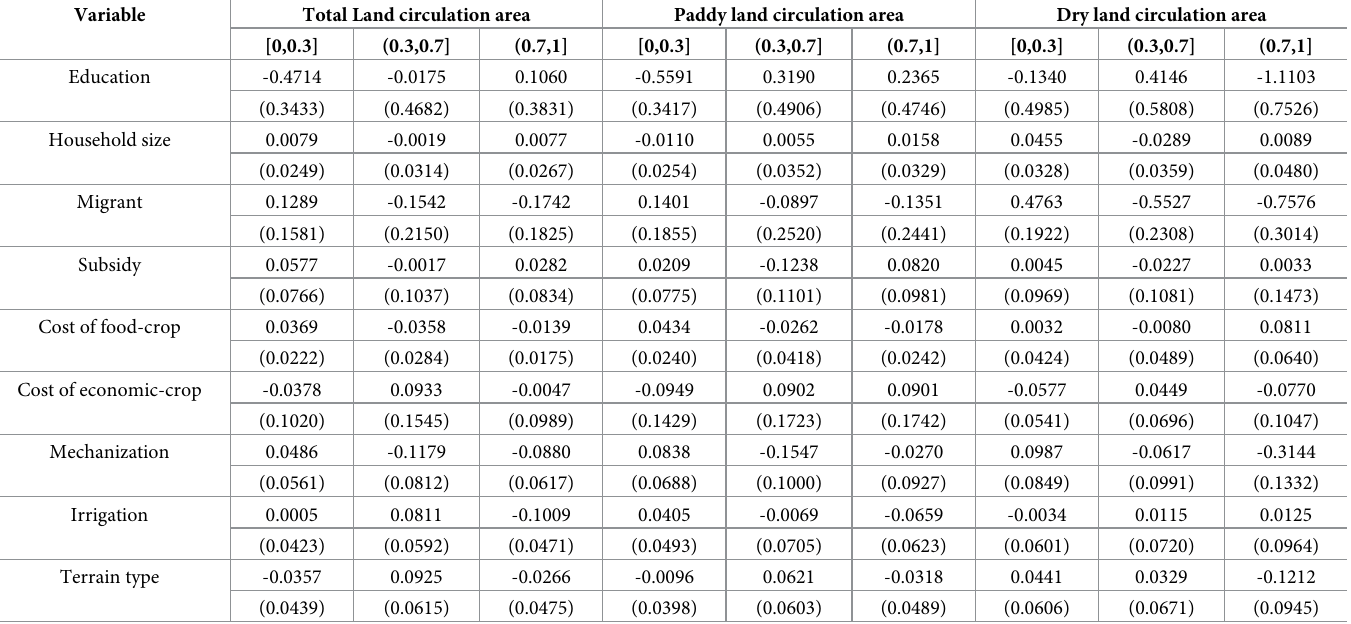
Table 3. GPSM estimation and balance test results of agricultural planting structure by land circulation